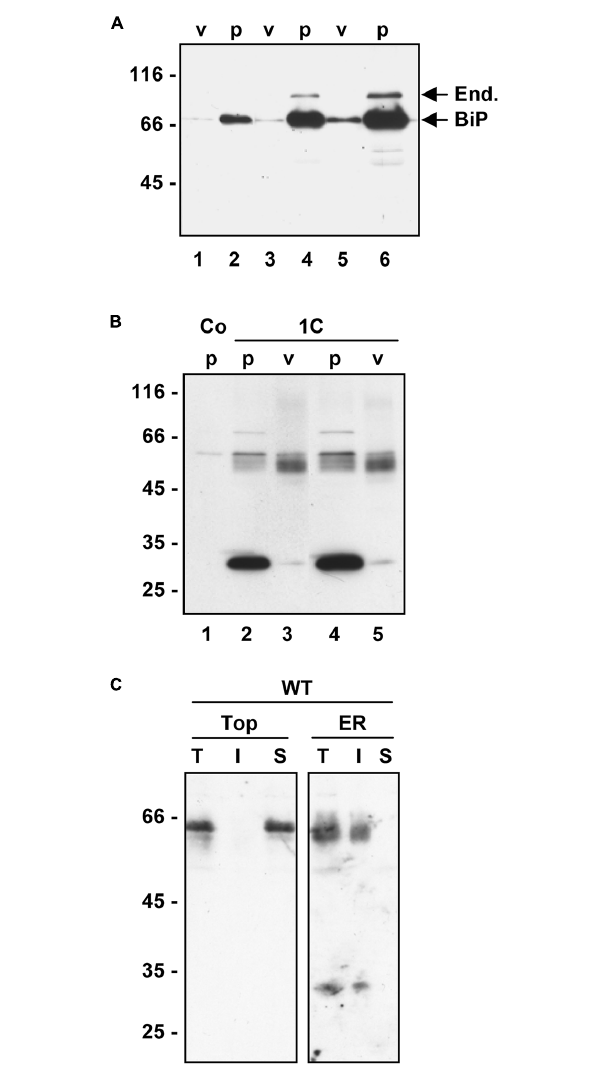
FIGURE 4 |Vacuole purification. (A) Tobacco protoplasts were transfected with empty plasmid. After 24 h incubation, either protoplast homogenates (p) or isolated vacuoles (v) were prepared and analyzed by SDS-PAGE and protein blot using a mixture of anti-BiP and anti-endoplasmin antisera. Lane 1 and 2: equal number of protoplasts and vacuoles, lanes 3 and 4 equal activity of the vacuolar enzyme α -mannosidase, lanes 5 and 6 fivefold amount of material with respect to lanes 3 and 4, respectively. (B) Tobacco protoplasts were transfected with empty plasmid (Co) or plasmid encoding 1C- γ -zein. After 24 h incubation, either protoplast homogenates (p) or isolated vacuoles (v) were prepared and analyzed by SDS-PAGE and protein blot using anti-flag antiserum. Lane 1-3: equal number of protoplasts and vacuoles, lanes 4 and 5 equal activity of the vacuolar enzyme α -mannosidase. (C) Tobacco protoplasts were transfected with plasmid encodingWT γ -zein. After 24 h incubation, protoplasts were homogenated in oxidizing conditions, in the absence of detergent and presence of sucrose.The homogenate was fractionated by isopycnic ultracentrifugation on sucrose density gradient.The fractions remaining on top of the gradient (top) or containing ER microsomes (ER) were diluted with homogenation buffer in oxidizing conditions and centrifuged. Equal amounts of total homogenate (T), soluble material (S) or insoluble precipitate (I) were analyzed by SDS-PAGE and protein blot using anti-flag antiserum. In each panel, numbers at left indicate the positions of molecular mass markers, in